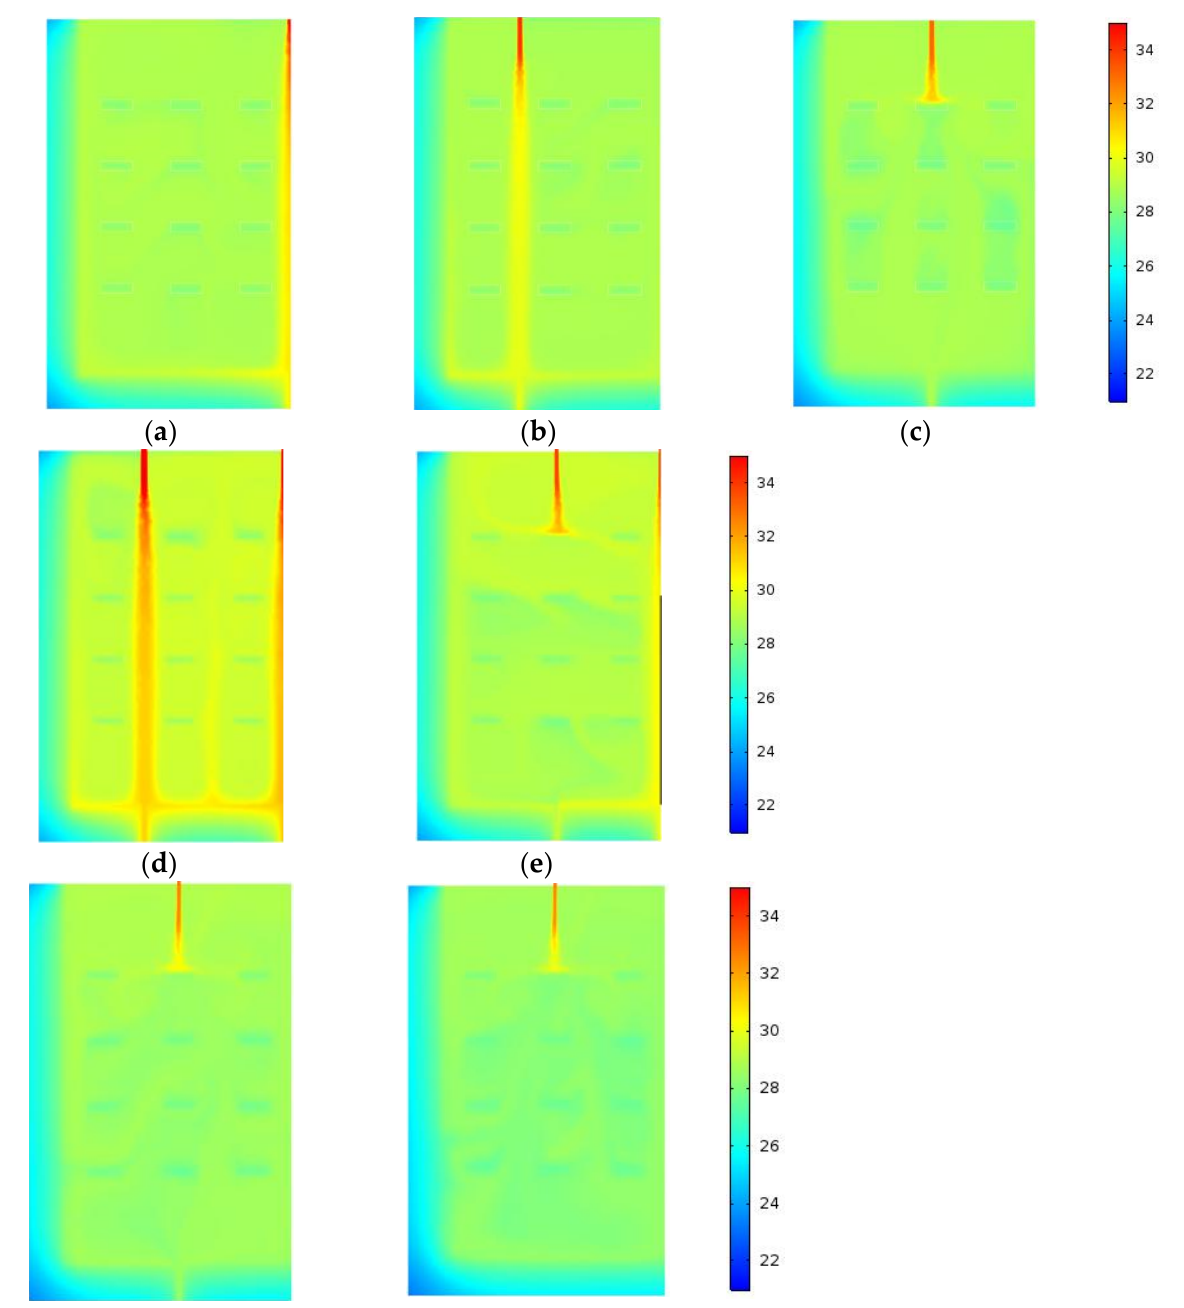
Figure 22. Flow field distribution chart of the reservoir under different water distribution modes: ( a ) one-inlet–one-outlet; ( b ) two-inlets–two-outlets-a; ( c ) two-inlets–two-outlets; ( d ) three-inlets– three-outlets-a; ( e ) three-inlets–three-outlets-b; ( f ) four-inlets–four-outlets; and ( g ) four-inlets– one-outlet.